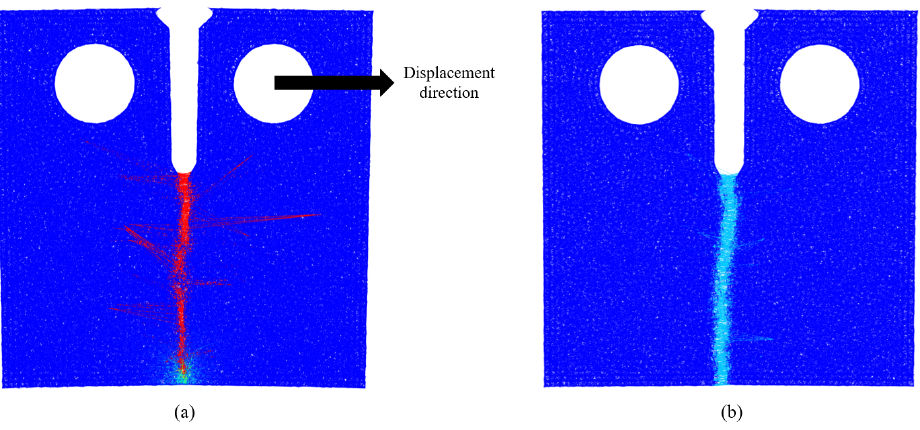
Figure 11. Crack propagation in the full MS CT specimen ( a ) and in the full MS-TiC CT specimen ( b ).